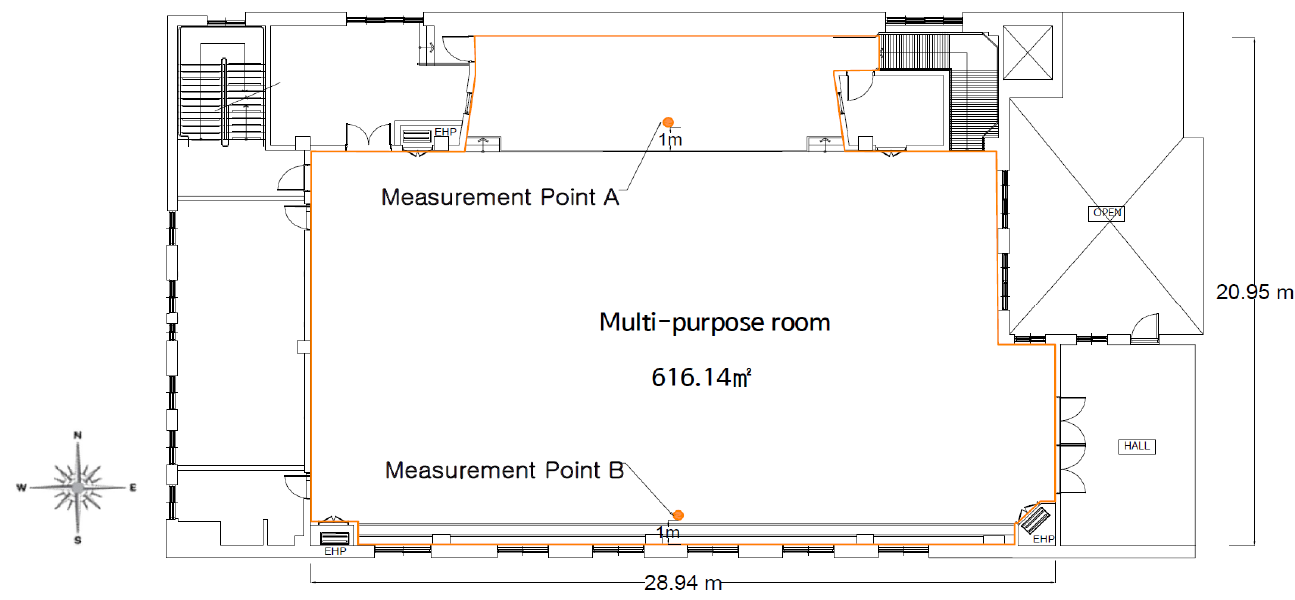
Figure 8. Floor plan of the MPA-space of A elementary school.